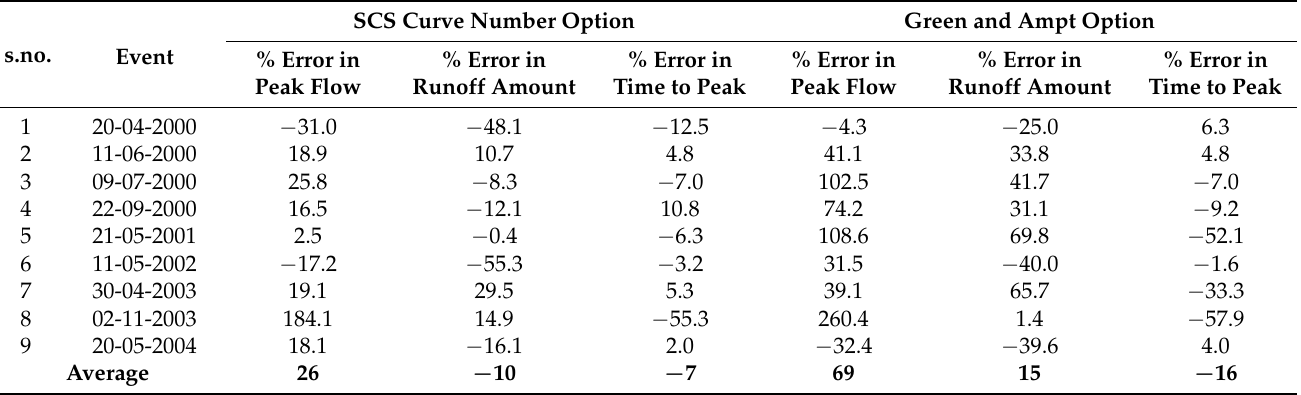
Table 12. Statistical comparison of runoff amount, peak flow, and time to peak using MFB-corrected radar rainfall data with SCS curve number and Green and Ampt runoff